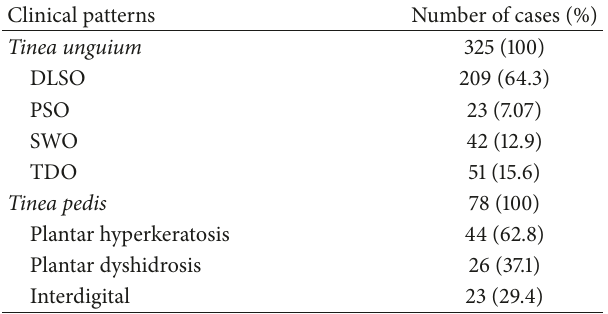
Table 3: Clinical patterns of foot